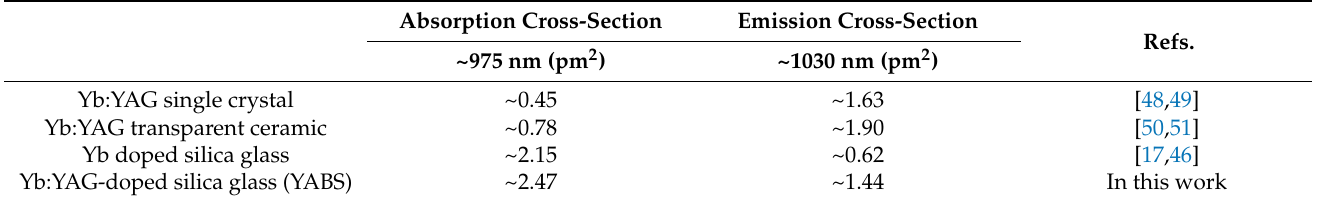
Table 4. Comparison of calculated absorption cross-sections at 975 nm and emission cross-sections at 1030 nm for Yb 3+ ions in different hosts with reported values. Absorption Cross-Section Emission